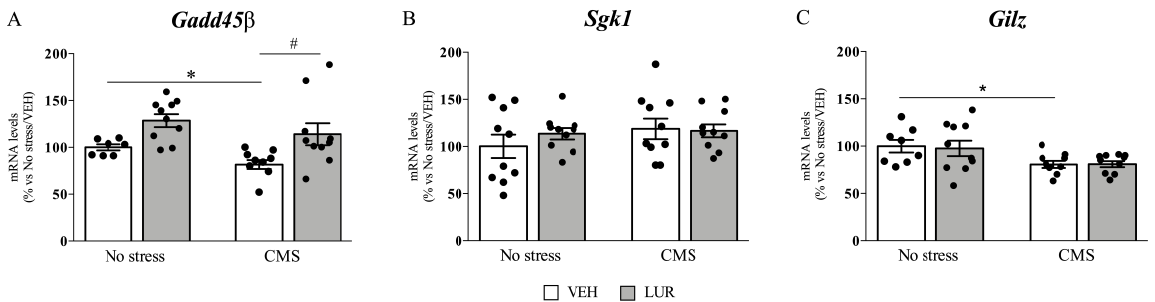
Figure 1. Analysis of Gadd45 β ( A ) Sgk1 ( B ) and Gilz ( C ) mRNA levels in the prefrontal cortex of chronically stressed rats: Modulation by chronic lurasidone (LUR) treatment. The data, expressed as a percentage of No stress/VEH animals (set at 100%), are the mean ± SEM. * p < 0.05 vs. No stress/VEH; # p < 0.05 vs. CMS/VEH (Two-way ANOVA with Tukey multiple comparison’s test ).